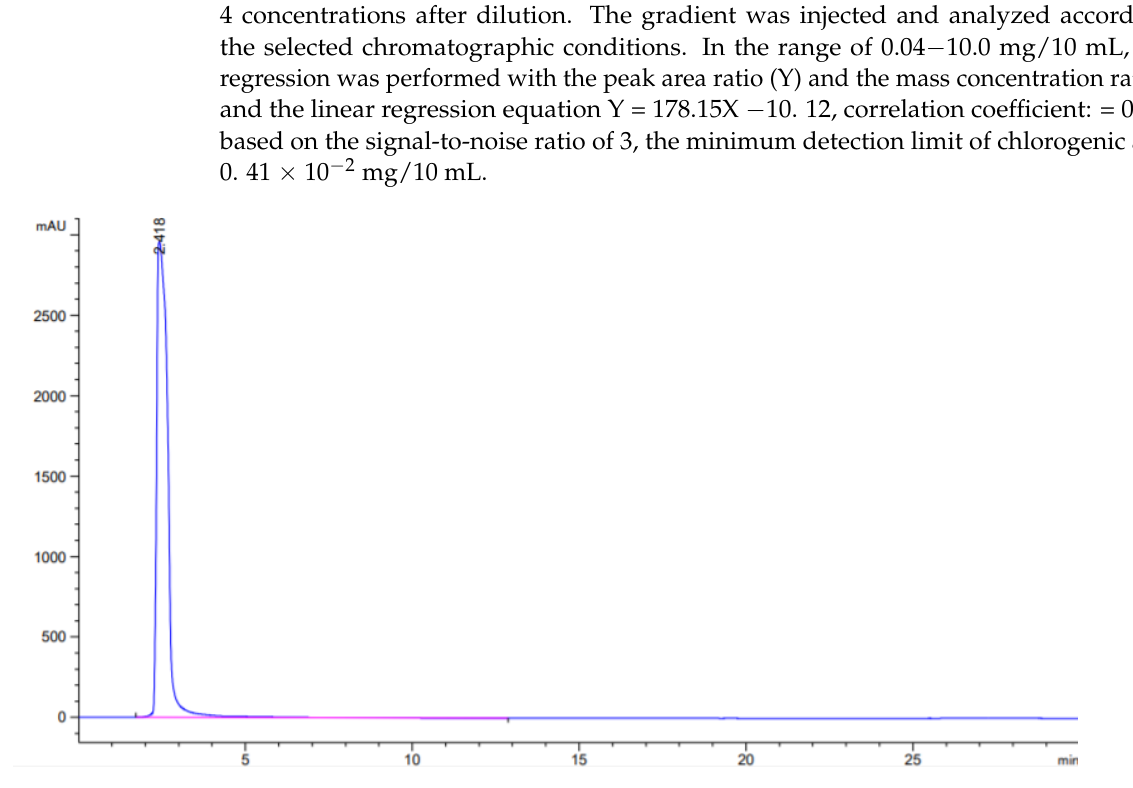
Figure 2 . HPLC chromatogram of chlorogenic acid in tobacco. Figure 2. HPLC chromatogram of chlorogenic acid in